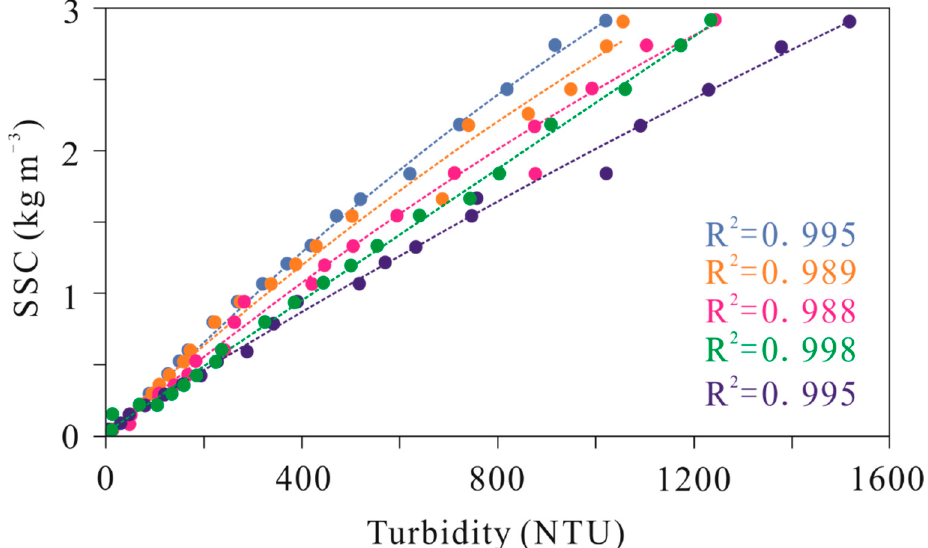
Figure 3. Calibration curves of turbidity obtained by five OBS and SSC.